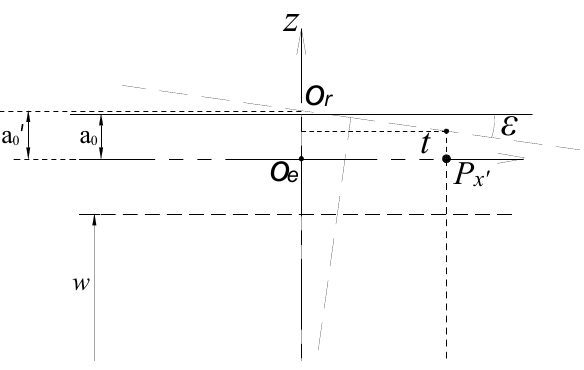
Figure 7. Schematic of the effect of tilt motion on the axial error motion measurement.